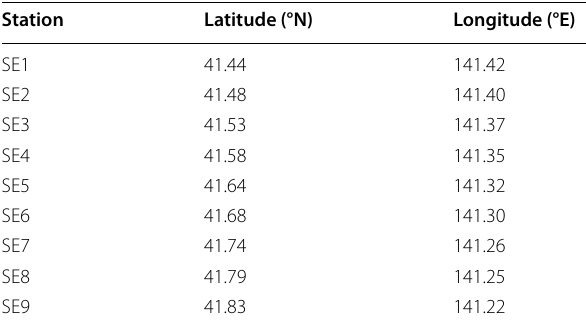
Table 1 Locations of the stations with repeated shipboard observations